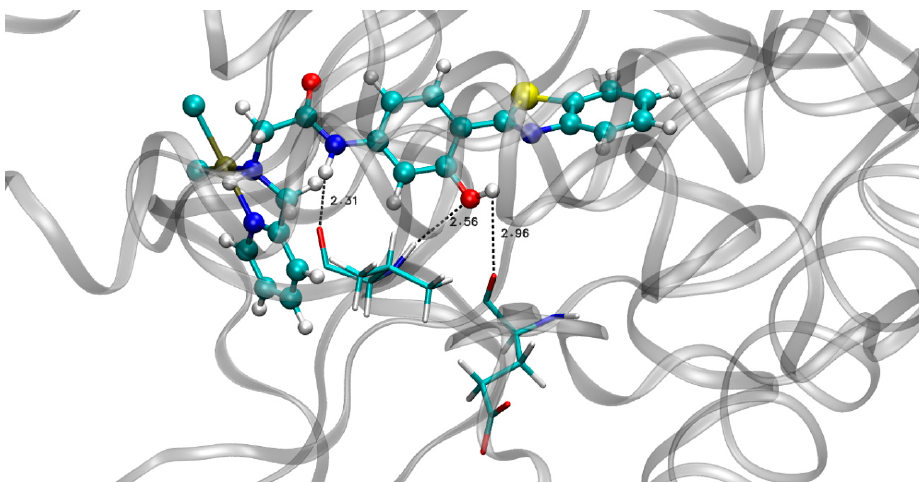
Figure 3. Best pose obtained by the docking study. At the bottom left, Val882 residue is forming two H-Bonds (2.31 Å and 2.56 Å) with PC. At the bottom right, an H-Bond (2.96 Å) can be seen between the Glu880 residue and PC.